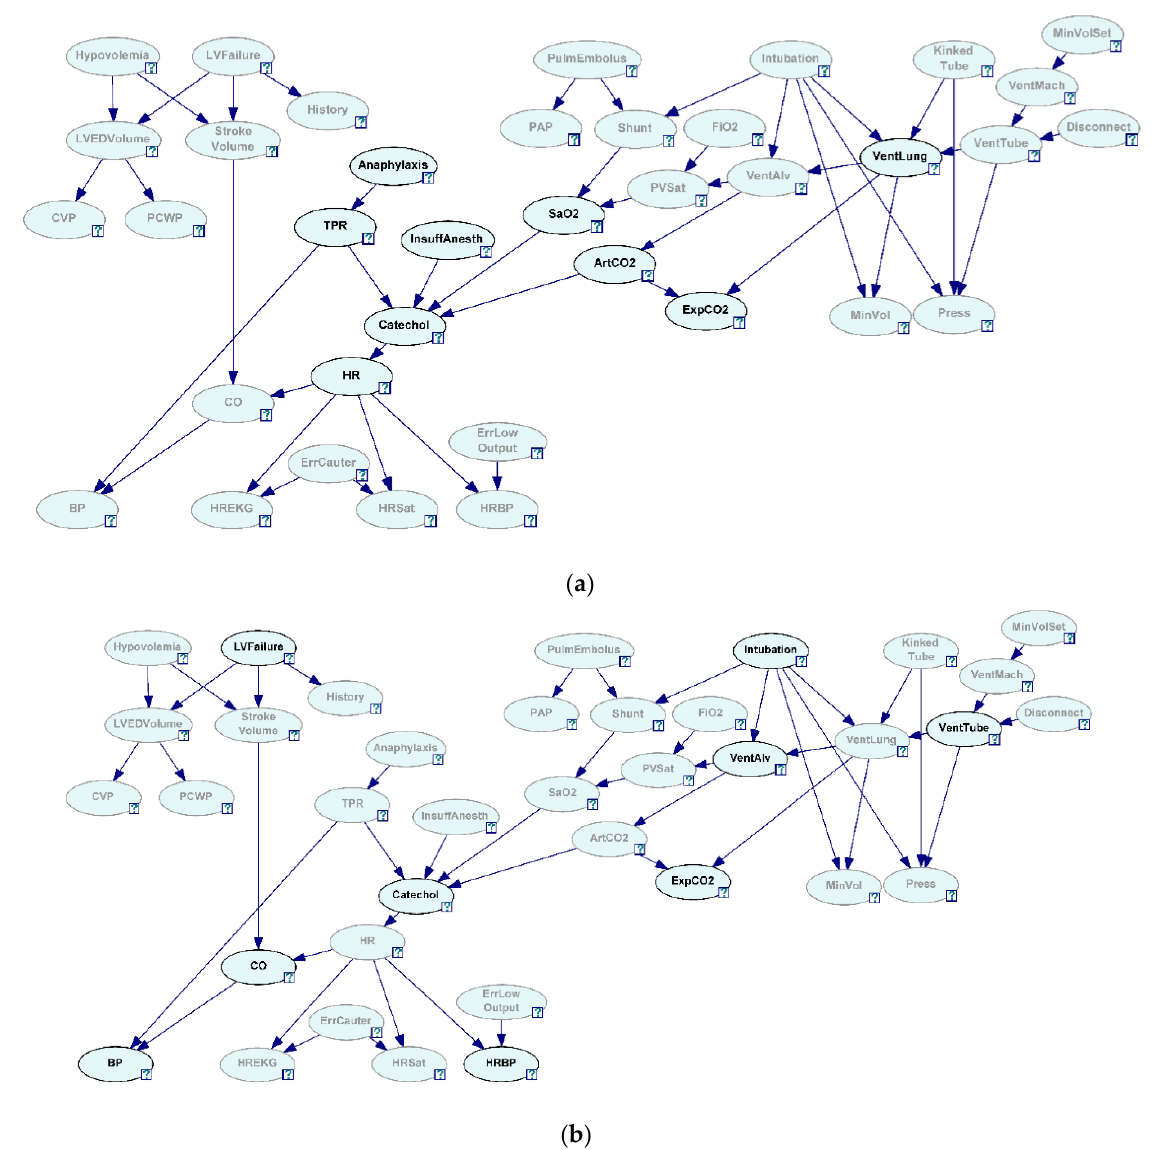
Figure 3. Two sets of nine variables. All the grayed-out variables are hidden and not selected. ( a ) Close 9 variables (C9). ( b ) Sparse 9 variables (S9).